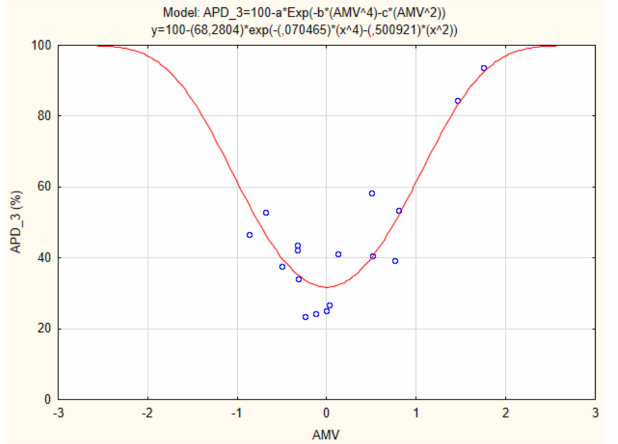
Figure 8. APD_3. The curve generated in Figure 8 is expressed by Equation (5):